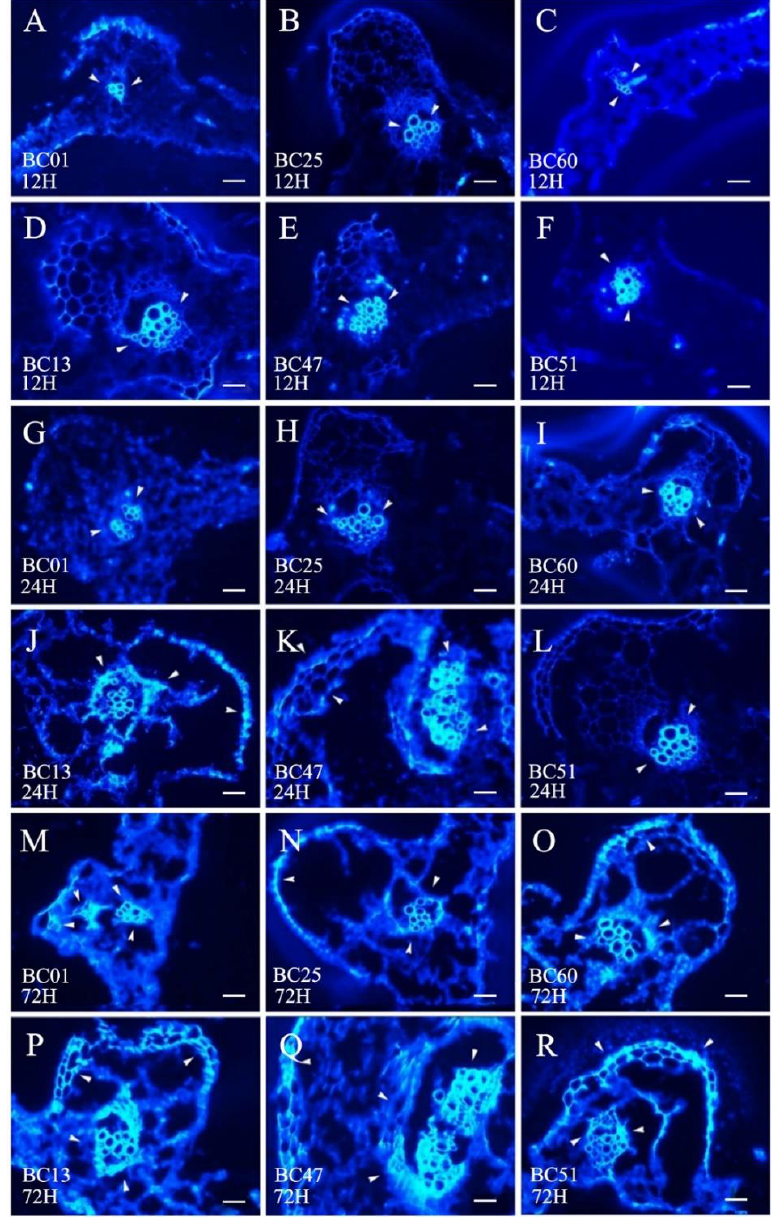
Figure 6. Comparison of callose deposition between the susceptible and the resistant Ethiopian mustards at different time points after infestation with GPA. Notes: ( A – F ) are 12 h after infestation with GPA between three susceptible accessions (BC01, BC25, and BC60) and three resistant accessions (BC13, BC47, and BC51); ( G – L ) are 24 h after infestation with GPA between the three susceptible accessions (BC01, BC25, and BC60) and three resistant accessions (BC13, BC47, and BC51); ( M – R )